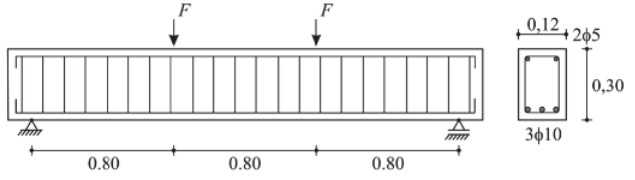
Simple supported RC beam. Dimensions in metre. Reinforcements